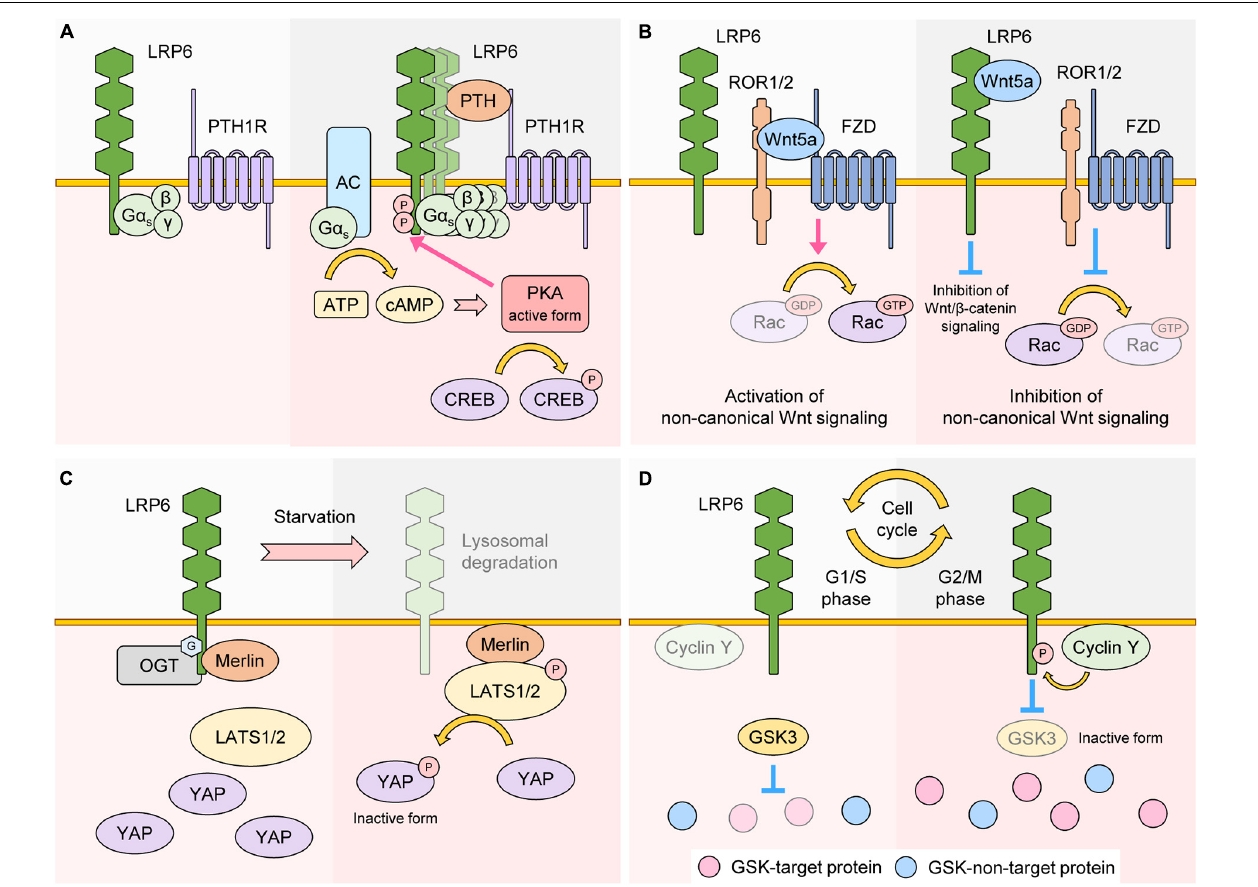
FIGURE 5 | Role of LRP6 as a regulator of other signaling. (A) LRP6 as a regulator of GPCR signaling. In the basal state, LRP6 interacts with G protein G α s . In the presence of the GPCR ligand PTH, a LRP6-PTH-PTH1R ternary complex is formed, which promotes aggregation of LRP6 and membrane localization of G α s . Production of cAMP is also upregulated in a G α s -AC-dependent manner. cAMP activates PKA, which promotes phosphorylation of LRP6 and CREB, two well-known downstream targets of PKA. (B) LRP6 as a regulator of non-canonical Wnt signaling. Wnt5a interacts with ROR1/2 and FZD, resulting in activation of Rac, a non-canonical Wnt signaling target. Wnt5a can also interact with LRP6. In these conditions, the binding affinity of ROR1/2 and FZD to Wnt5a is reduced. As a result, Rac becomes inactive and non-canonical Wnt signaling is inhibited. Because LRP6-Wnt5a binding weakens LRP6-Wnt3a interaction, Wnt/ β -catenin signaling is also inhibited. (C) LRP6 as a regulator of Hippo signaling. In a nutrient rich state, LRP6 is O -GlcNAcylated and interacts with Merlin. In this condition, activity of LATS1/2 is maintained at low levels, resulting in stabilization and activation of YAP. In nutrient starvation conditions, O -GlcNAcylation and protein levels of LRP6 are both downregulated, and Merlin changes its binding partner from LRP6 to LATS1/2, resulting in activation of LATS1/2. YAP is phosphorylated by LATS1/2 and becomes inactive. (D) LRP6 as a regulator of Wnt/STOP signaling. In G1/S phase, cyclin Y protein levels are less abundant and the phosphorylation state of LRP6 is low, resulting in higher GSK3 activity. GSK3-target proteins are thus phosphorylated and targeted for proteasomal degradation. In G2/M phase, cyclin Y protein levels peak and promote LRP6 phosphorylation, resulting in inactivation of GSK3 and stabilization of GSK3-target